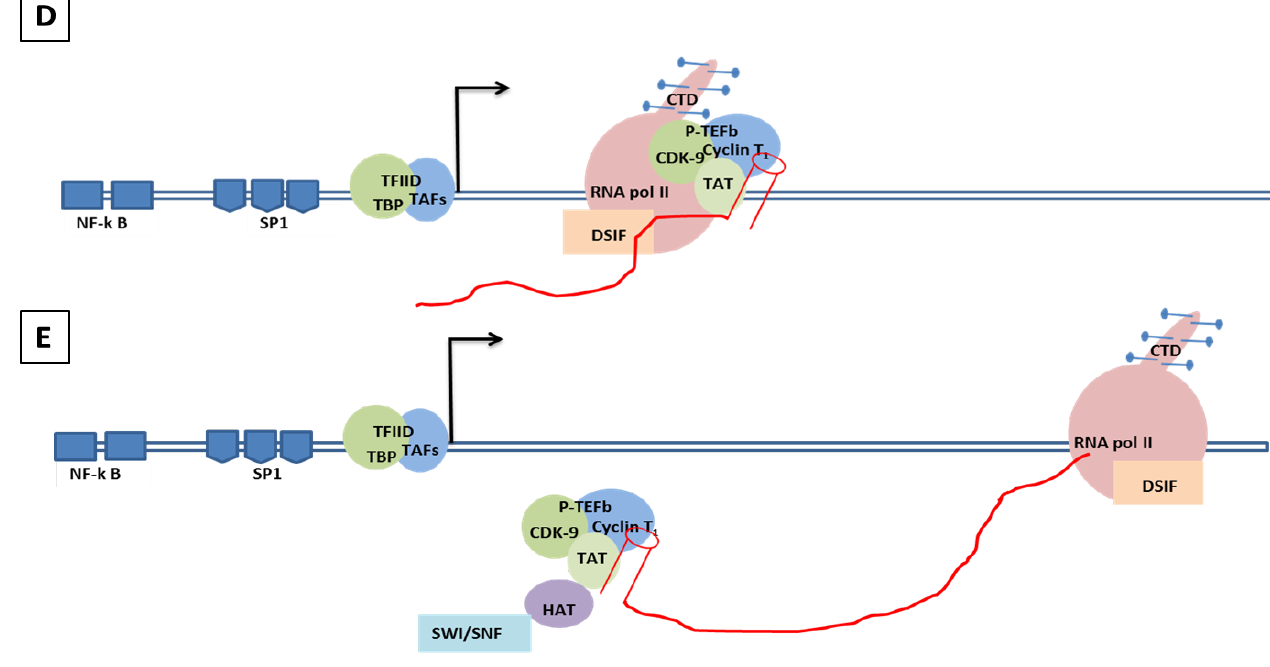
Figure 5. Genomic organization of HIV-1 and mechanisms of LTR transactivation. ( A) The modulatory region consists of transcription factors such as COUP, AP1,